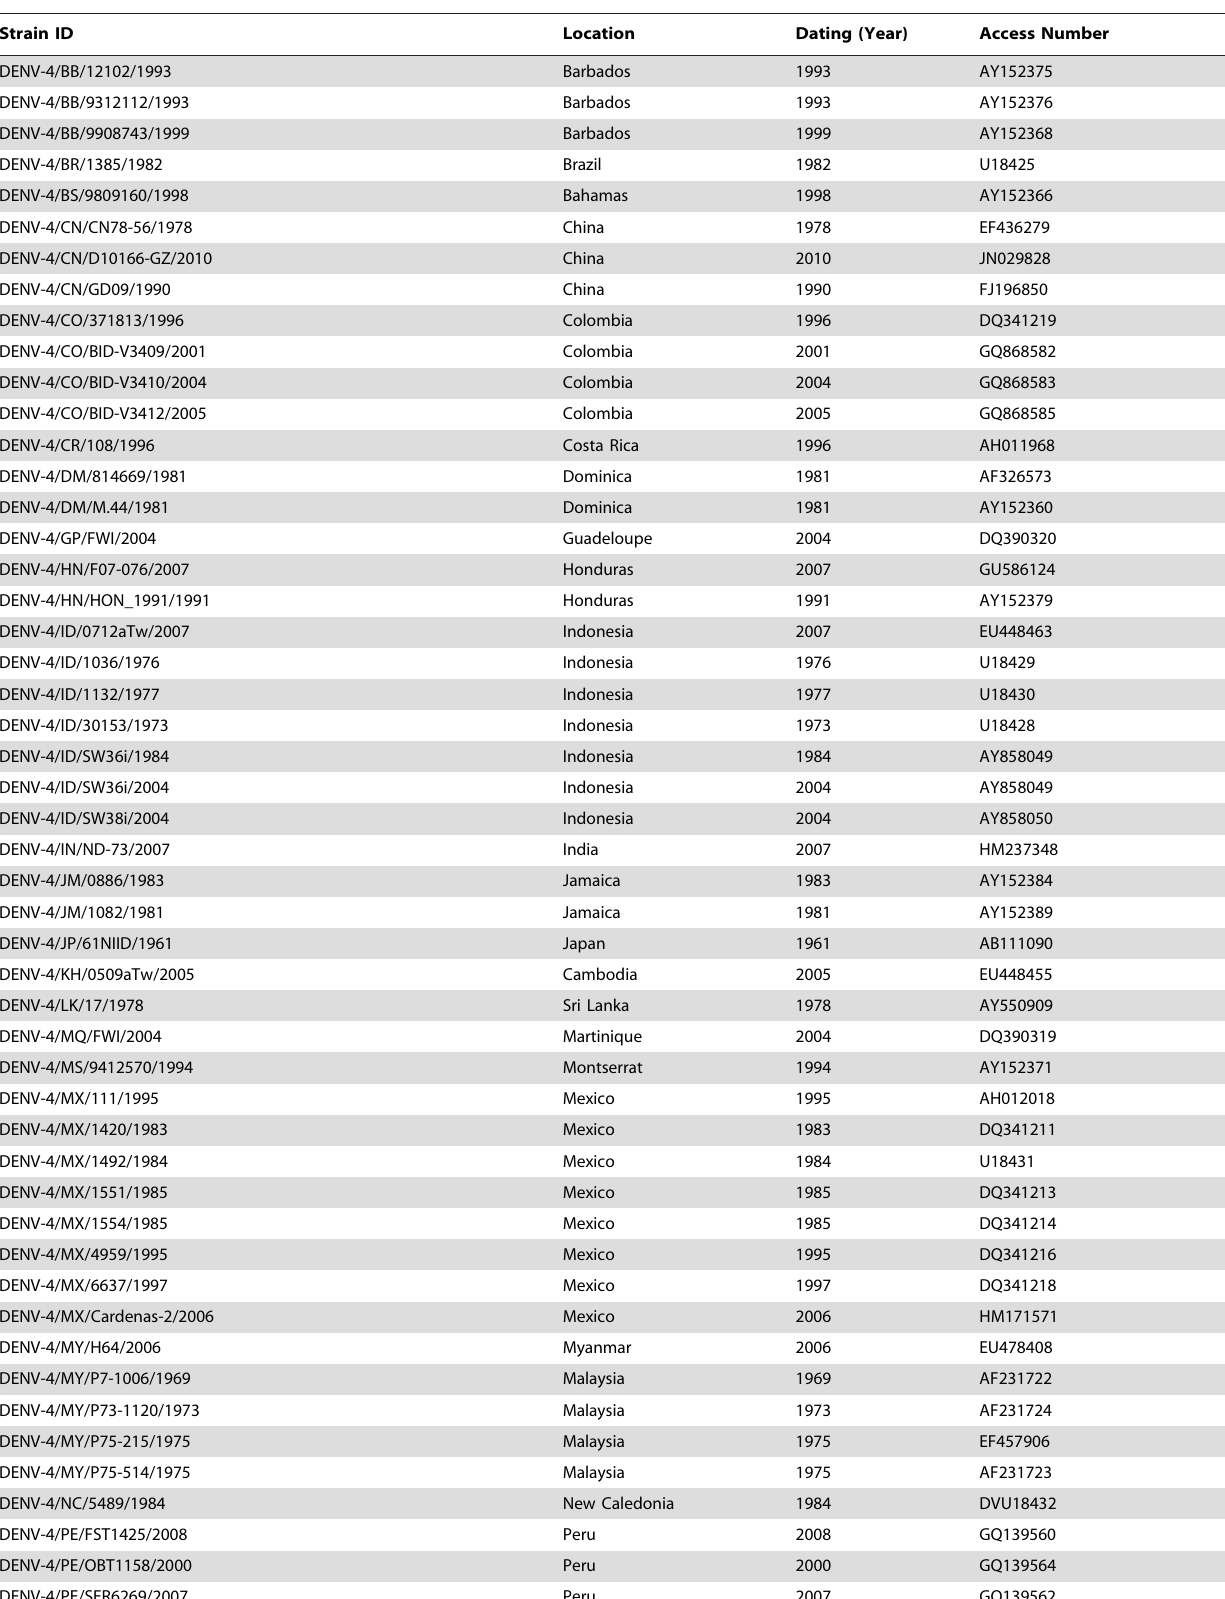
Table 1. DENV-4 virus strains included in phylogenetic analysis of envelope